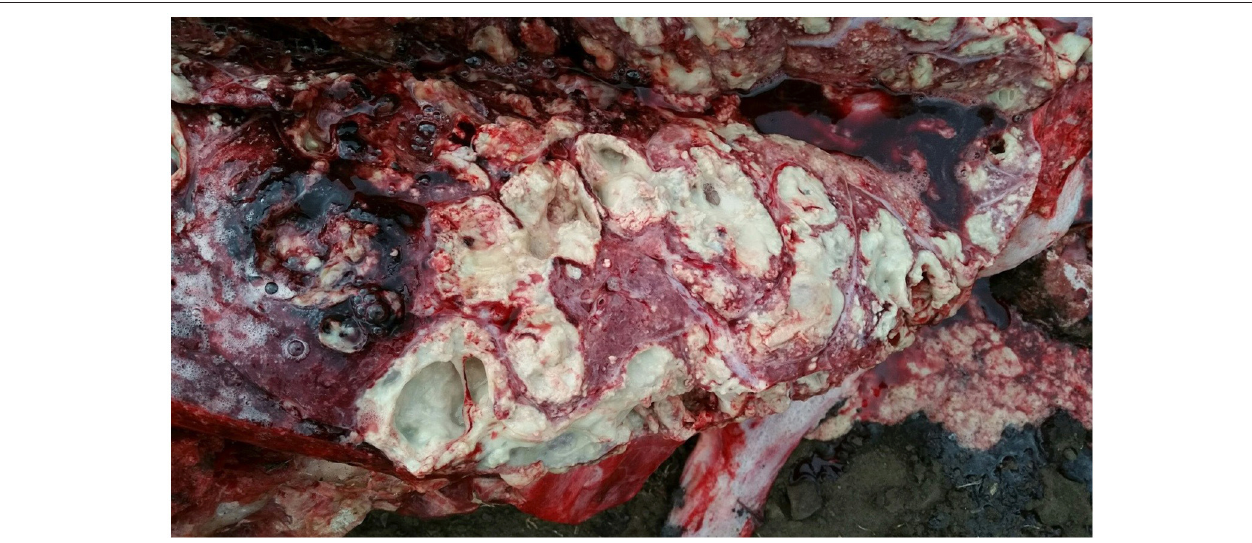
FIGURE 1 | Image of gross pathological changes in lungs of African elephant with Mtb disease. Lung lesions consisted of multifocal to coalescing encapsulated cavities (10–15cm in